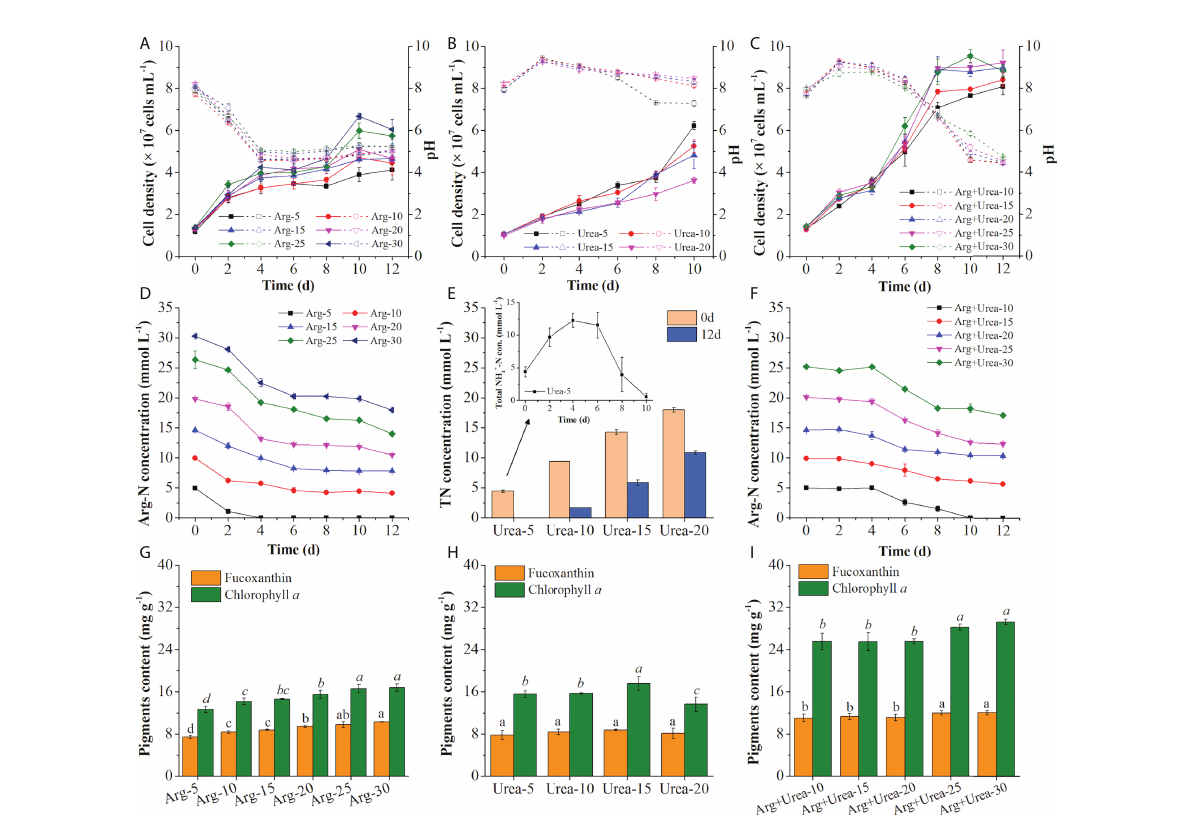
FIGURE 6 Cell density and pH value (A – C) , TN concentration in the medium (D – F) , and pigment contents (G – I) using Arg (5,10, 15, 20, 25, 30 mmol N L − 1 ) (A, D, G) , urea (5, 10, 15, 20 mmol N L − 1 ) (B, E, H) , and the mixture of Arg and urea (10, 15, 20, 25, 30 mmol TN L − 1 , in which urea was at 5 mmol N L − 1 ) (C, F, I) as nitrogen sources. The solid and dotted lines represent cell density and pH value (A – C) , respectively. Total NH 4+ -N concentration (con.) represents NH 4+ from the decomposed urea and secreted NH 4+ from cells (E) . Different letters indicate a signi fi cant difference ( p<